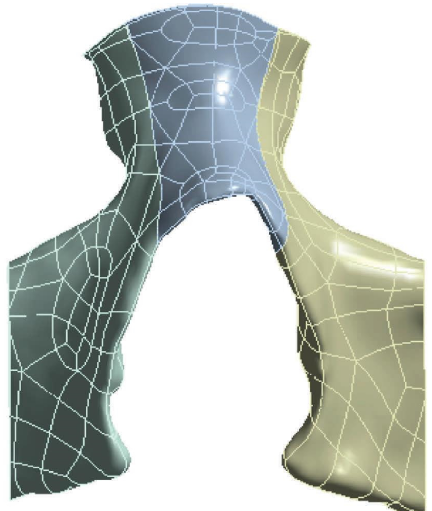
Figure 2: Positioning of the upper, middle, and lower segments of nasal bone and the junction of nose and